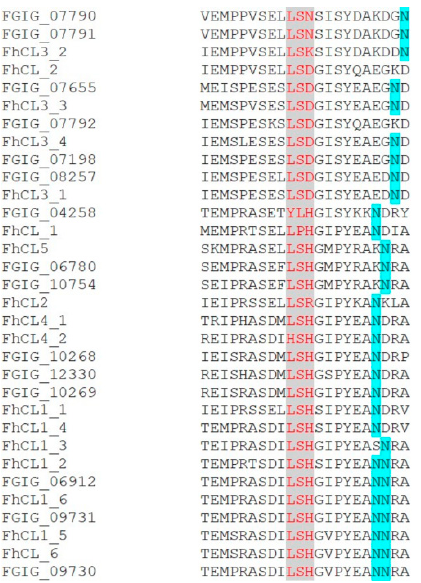
Figure 4. Alignment of the amino acid sequence spanning the junction between the propeptide and mature domain of the F. hepatica and F. gigantica cathepsin L peptidase families. The conserved cathepsin L intra-molecular cleavage site and the conserved asparagine (N) of the legumain/asparaginyl endopeptidase trans-molecular cleavage site are highlighted in grey/red and blue, respectively. The F. hepatica cathepsin L peptidase classification is based on the study by Cwiklinski et al. [4]. The F. gigantica sequences are from the F. gigantica genome (PRJNA230515).